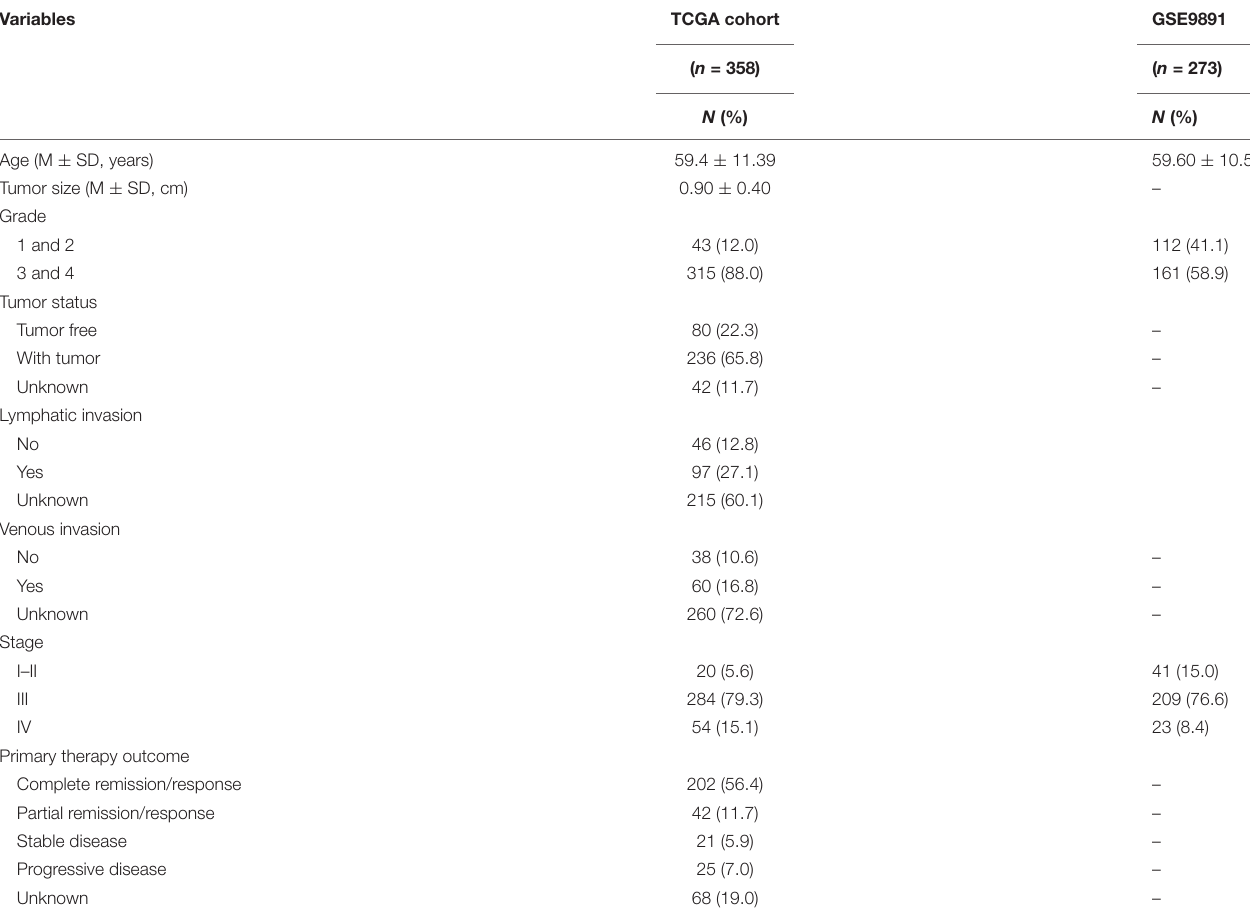
TABLE 1 | Clinicopathologic characteristics of ovarian cancer (OC) patients in The Cancer Genome Atlas (TCGA) and Gene Expression Omnibus (GEO)